Question: Looking at the figure, what chart type is it?
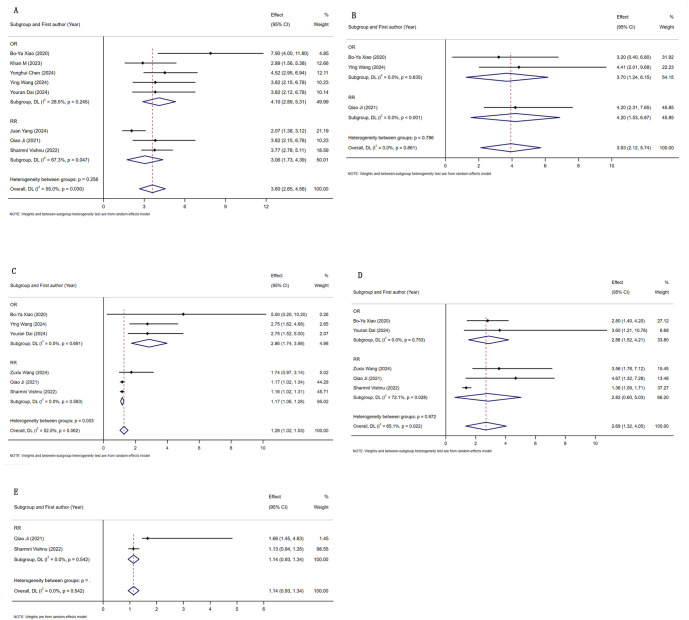
Answer: forest